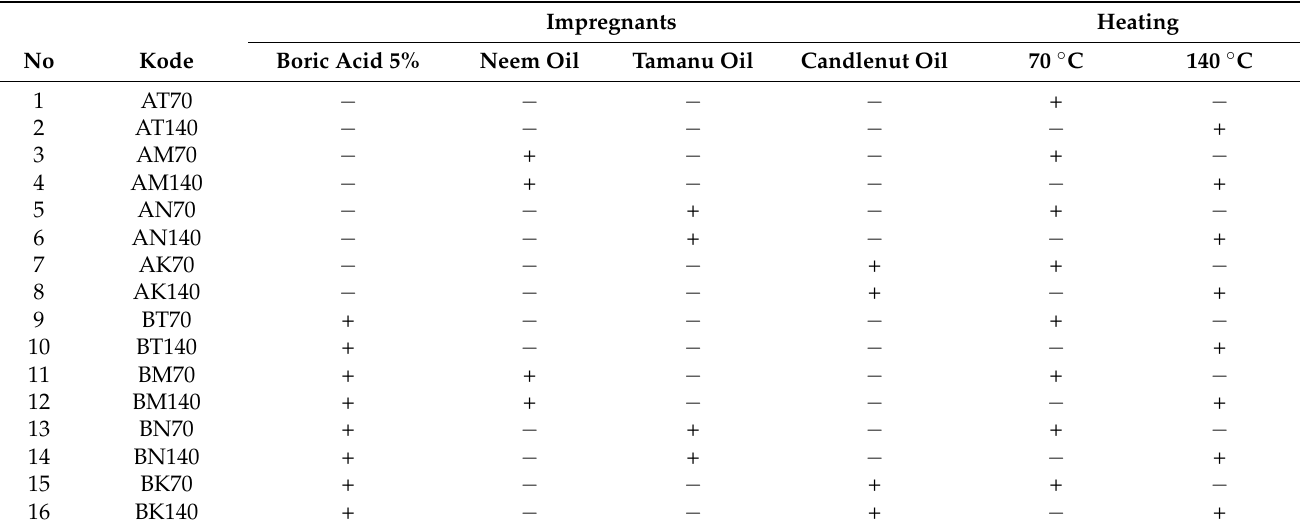
Table 2. Treatment combinations used with manii wood.